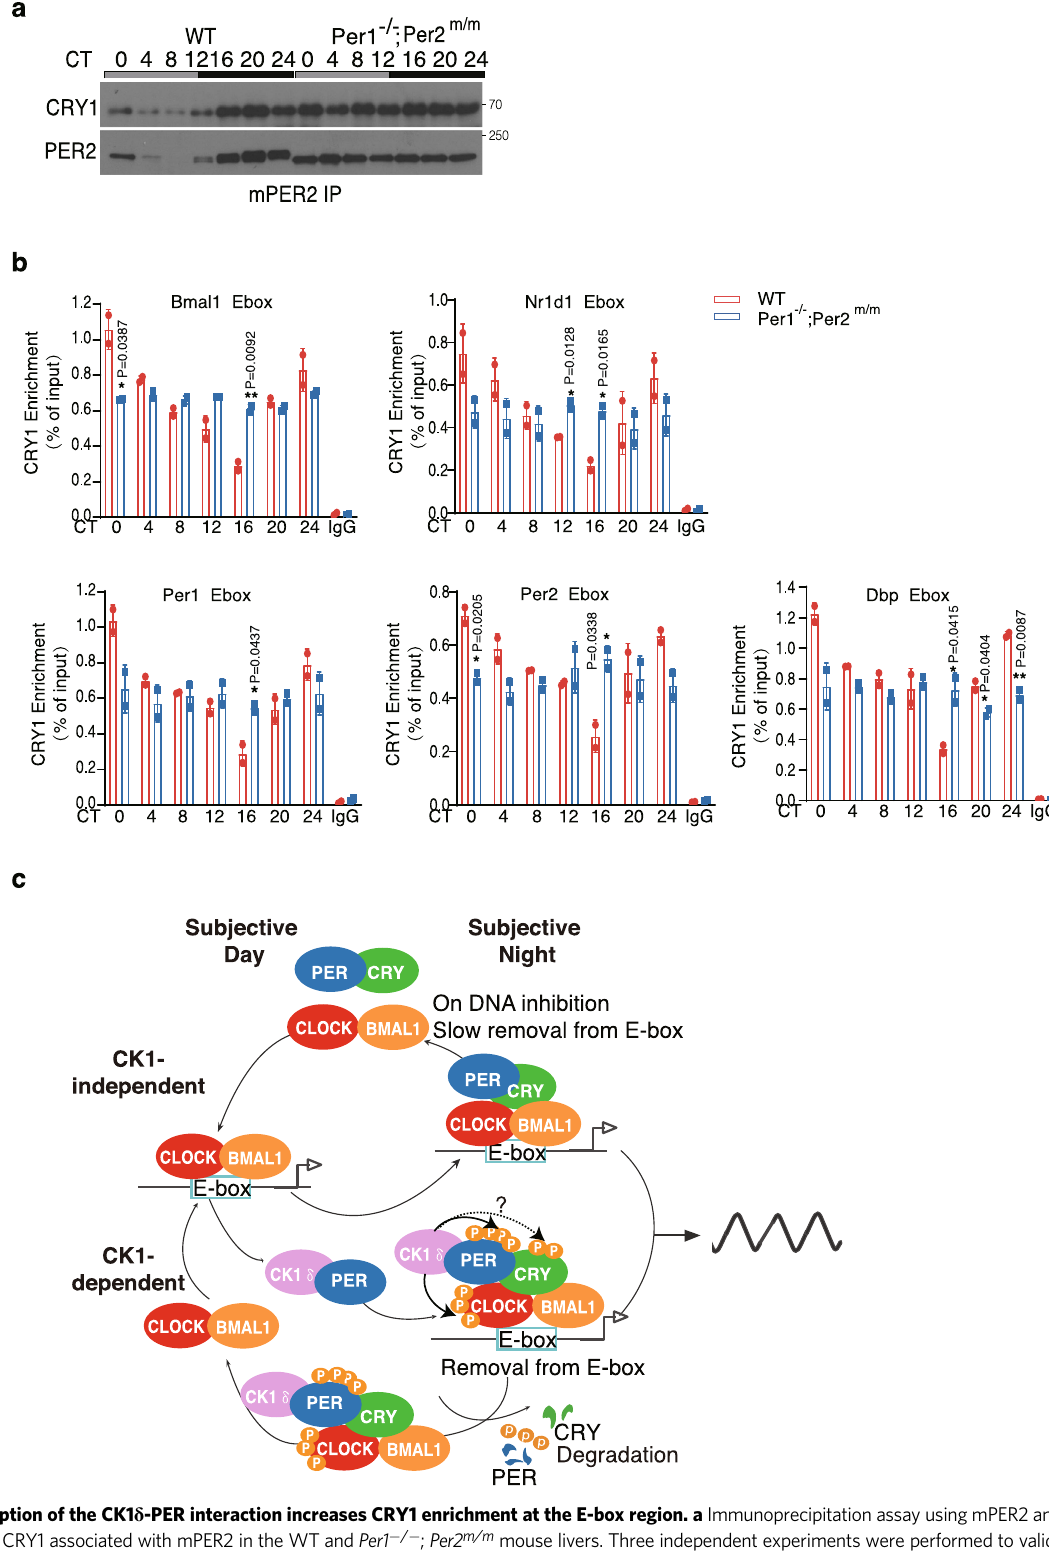
Fig. 7 Disruption of the CK1 δ -PER interaction increases CRY1 enrichment at the E-box region. a Immunoprecipitation assay using mPER2 antibody showing the levels of CRY1 associated with mPER2 in the WT and Per1 − / − ; Per2 m/m mouse livers. Three independent experiments were performed to validate the results. b CRY1 ChIP assay results showing the relative CRY1 enrichment at the E-box region of the indicated gene promoters at the indicated time points in the WT and Per1 − / − ; Per2 m/m mice. Chromatin samples from mouse livers were analyzed by ChIP using CRY1 antibody. Error bars are standard deviations. * p value<0.05 and ** p value<0.01 (two-sided t -test). c A model of the coupled CK1-dependent and CK1-independent negative feedback loops in the core mammalian circadian oscillator. During subjective days, the PER levels are low and CLOCK-BMAL is associated with E-box and active. During the subjective night, PER and CRY levels are high. The CK1-dependent negative feedback process (bottom) involving CK1, PER, and CRY that mediates ef fi cient removal CLOCK-BMAL1 from the E-boxes by promoting PER-dependent phosphorylation of CLOCK by CK1. The CK1-independent process (top) results in the repression of the CLOCK-BMAL1 complex transcription activation activity by the PER-CRY complex on DNA. This process also causes slow removal of CLOCK-BMAL1 complex from E-boxes. NATURE COMMUNICATIONS| (2022) 13:3991